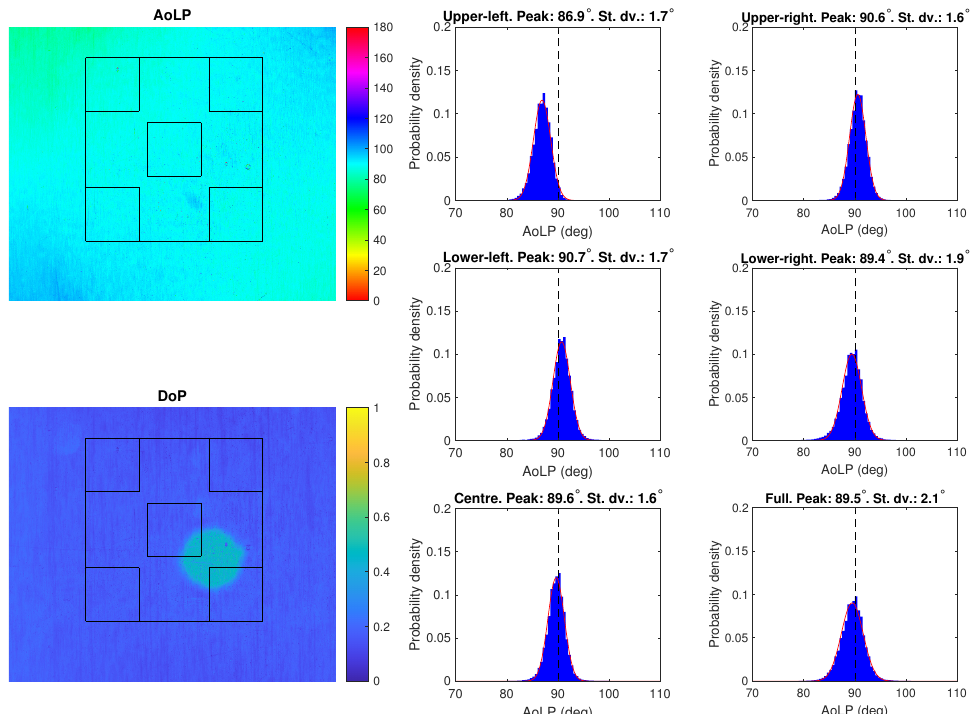
Figure 22. Results of identical experiment to that in Figure 21 but with a 23 mm